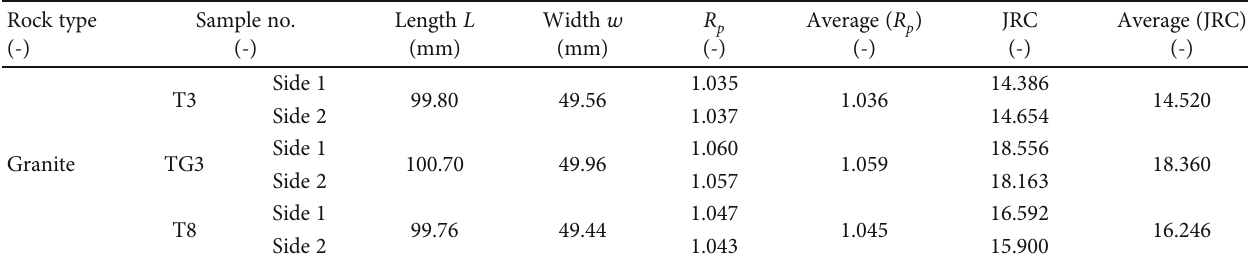
Table 1: Geometrical parameters for each sample.